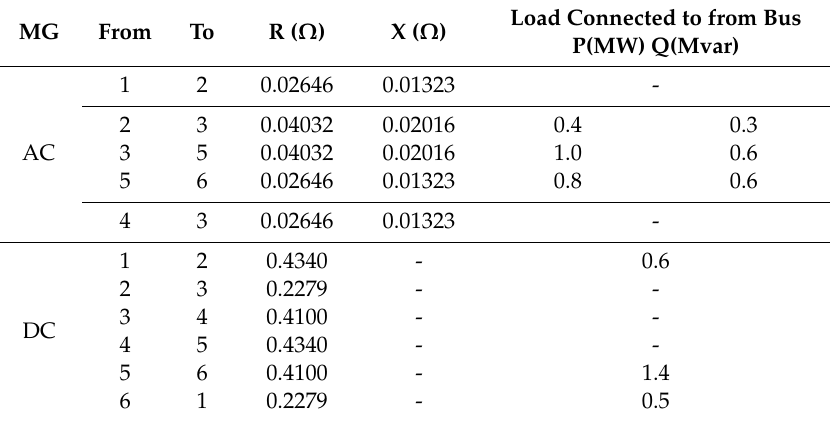
Table 11. Line / Load data for the 12-bus IHMG